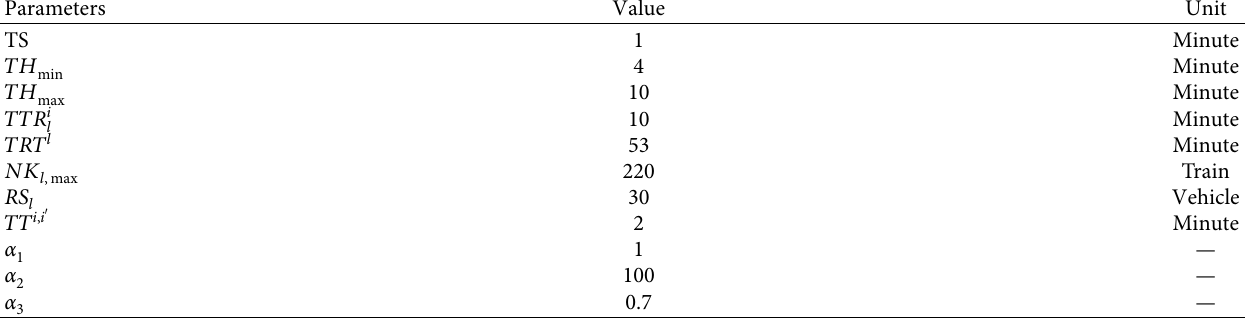
Table 15: The values of real-world case train operation